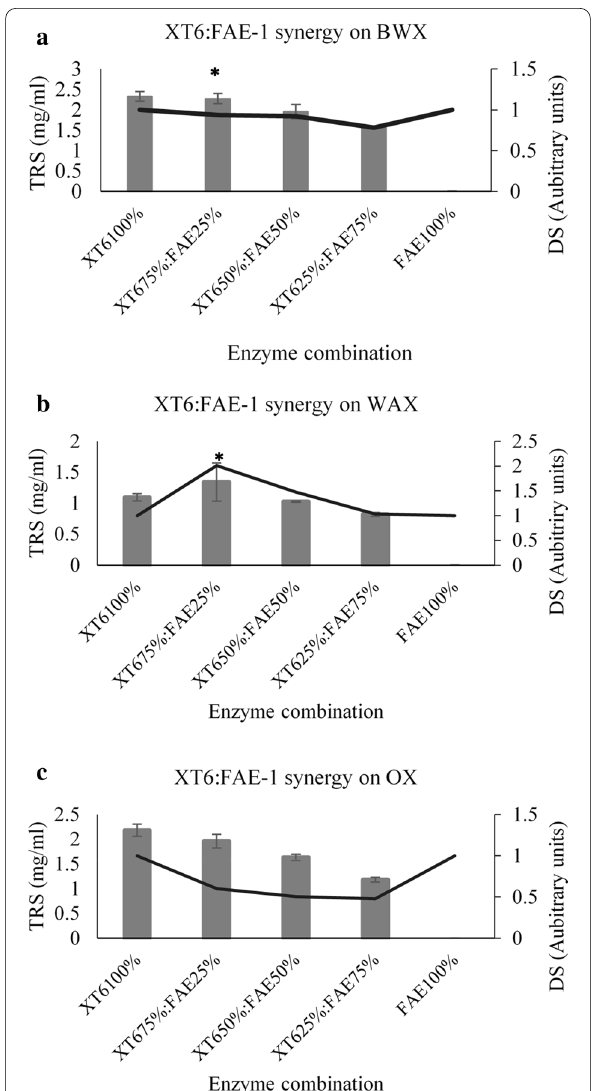
Fig. 3 Synergistic hydrolytic activities of the GH10 xylanase (XT6) and feruloyl esterase (FAE-1) on beechwood xylan ( a ), insoluble wheat arabinoxylan ( b ) and oat spelt xylan ( c ). The TRS represent the amount of released total reducing sugars from xylan and DS represents the degree of synergy formed between two enzymes. ANOVA analysis indicated the improvement of reducing sugar release by the enzyme combinations compared to lone enzyme protein loading, keys: *(p value < 0.05) and #(p value < 0.01). Values are represented as mean values SD (n 3) ± =